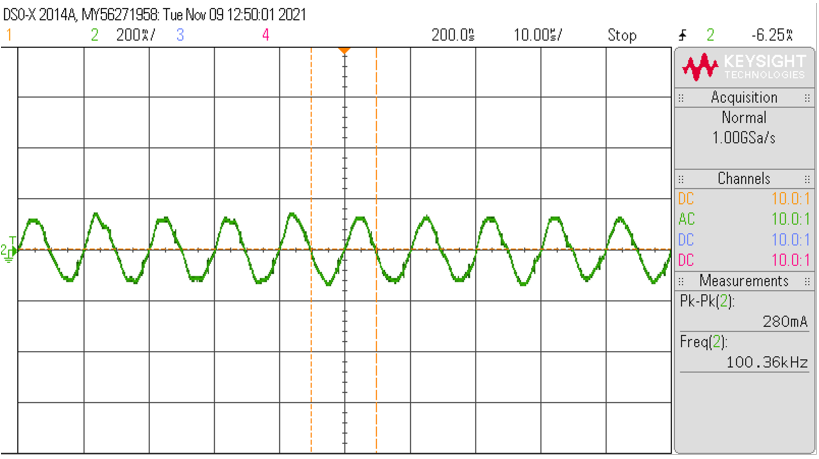
Figure 31. Oscilloscope’s printed screen from the inductance current